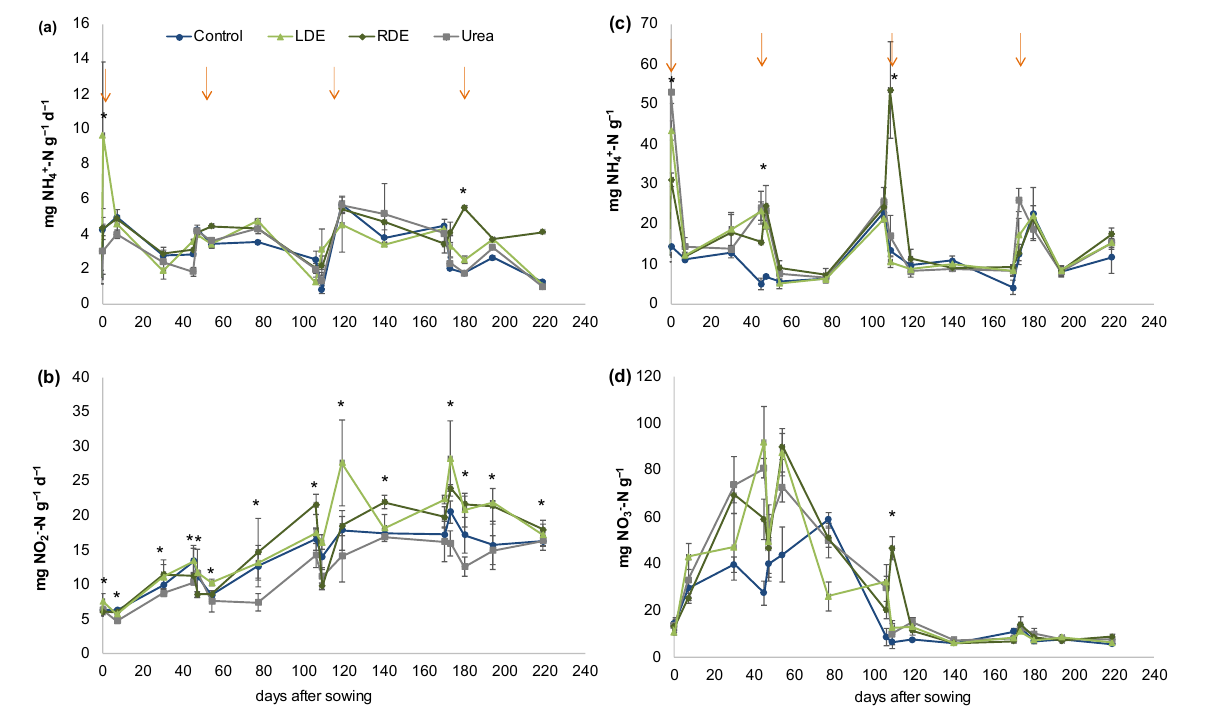
Figure 2. Nitrogen dynamics in soil with fescue pasture with application of Raw (RDE) or Lagoon Dairy effluent (LDE), urea, and non-amended control (mean n = 3 ± S.E). Potentially mineralizable nitrogen ( a ), Potential nitrification activity ( b ), Ammonium (NH 4+ –N) content ( c ), Nitrate (NO 3 − –N) content ( d ). Arrows indicate treatment application. Asterisks indicate sampling dates with signifi- cant differences within treatments at p < 0.05.